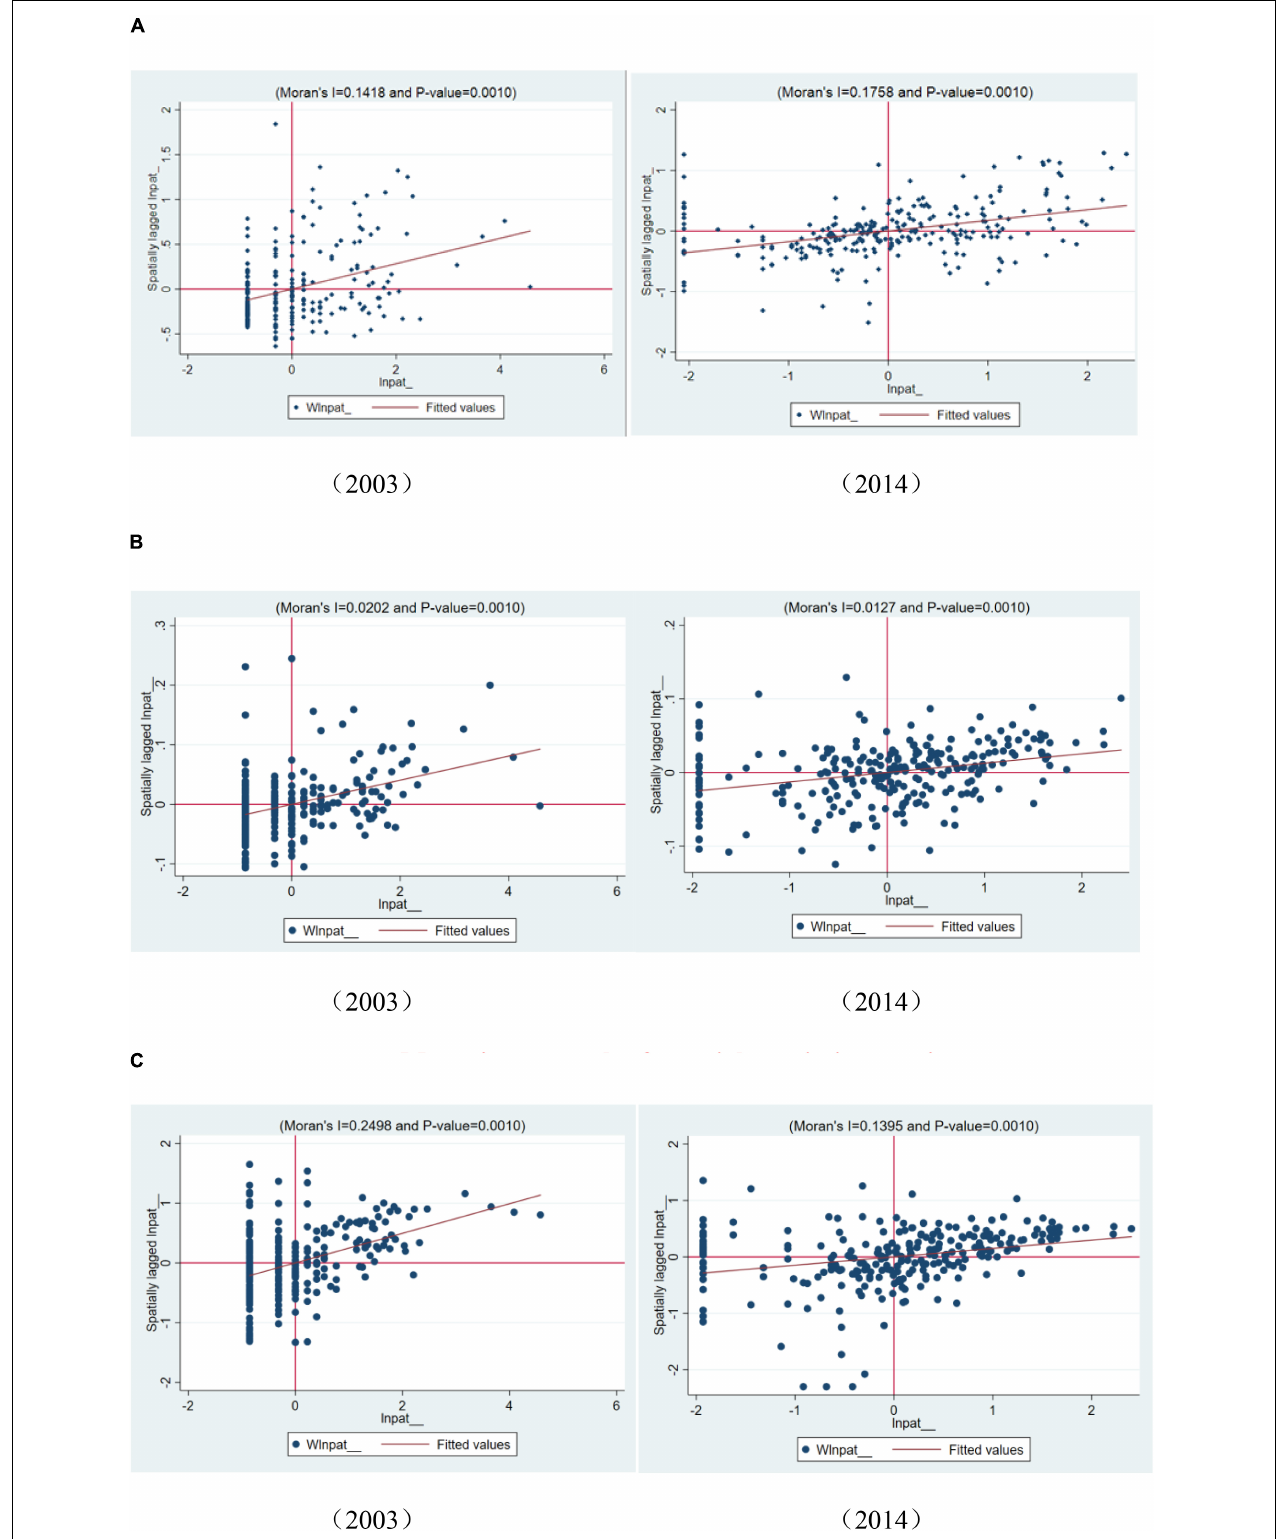
FIGURE 1 | Moran’s scatter plot for geographic, social, and cognitive matrixes. (A) Moran’s scatter plot for geographical proximity matrix. (B) Moran’s scatter plot for cognitive proximity matrix. (C) Moran’s scatter plot for social proximity matrix.